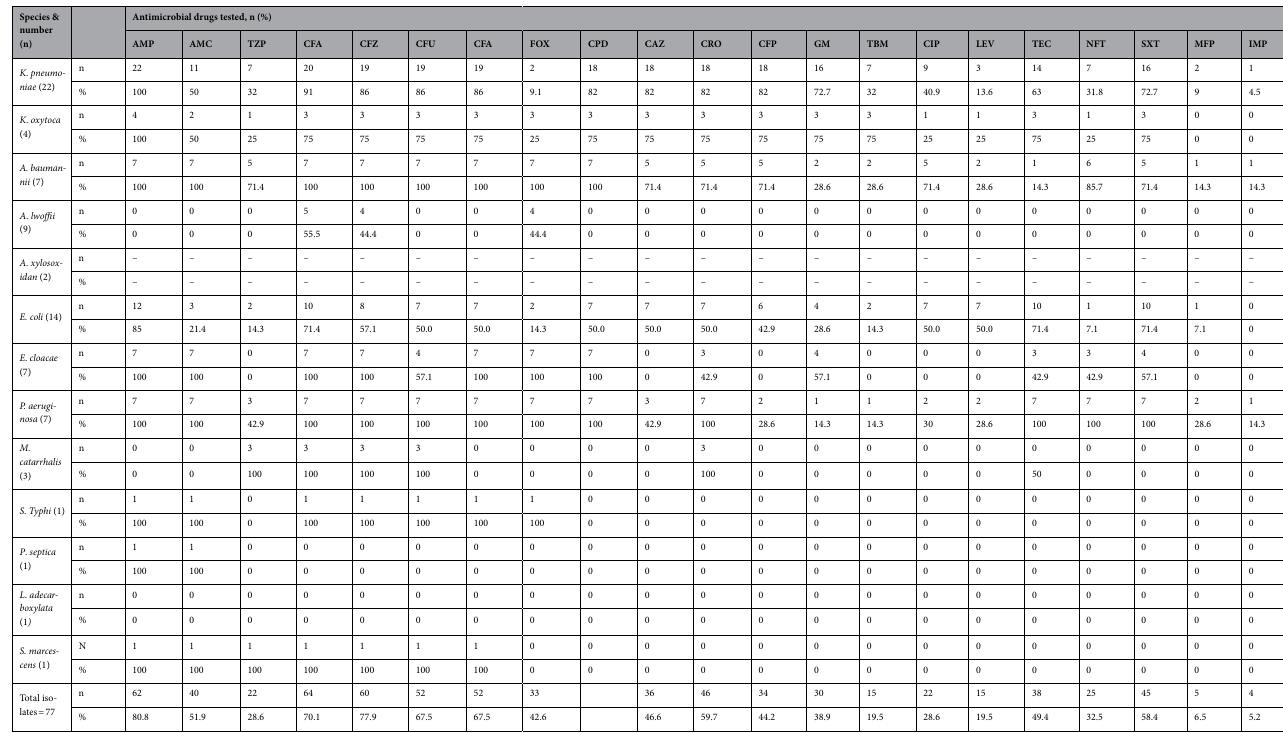
Table 3. Percentage antimicrobial resistance profile of blood-born Gram-negative bacteria. AMP ampicillin, AMC amoxicillin/clavulanic acid, TZP piperacillin/tazobactam, CFA cephalothin, CFZ cefazoline,